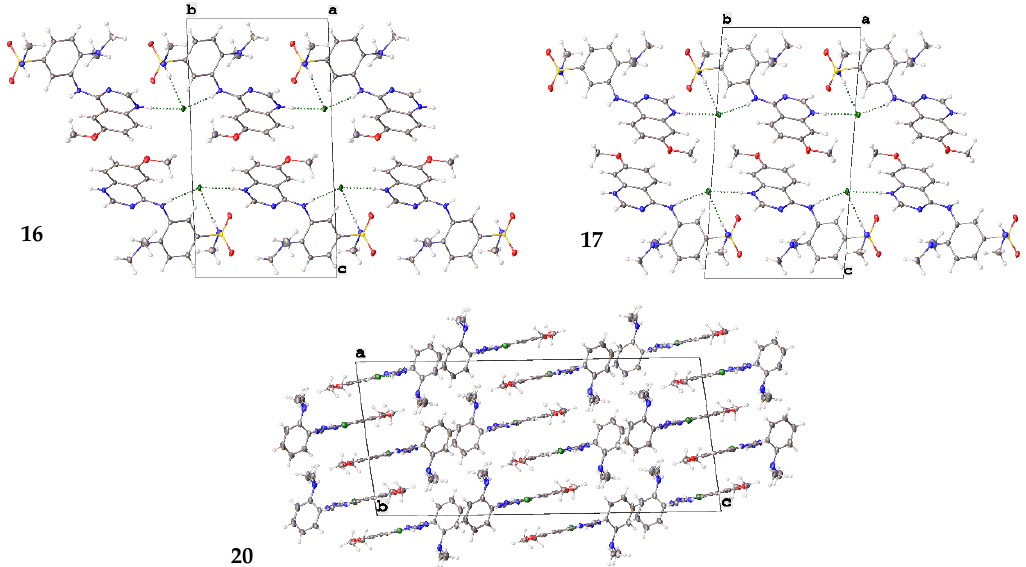
Figure 7. Unit cell contents of 16 H + Cl − , 17 H + Cl − and 20 H + Cl − shown in projection down the a -axis ( 16 , 17 ) or b -axis ( 20 ). Hydrogen bonds are shown as dashed green lines.